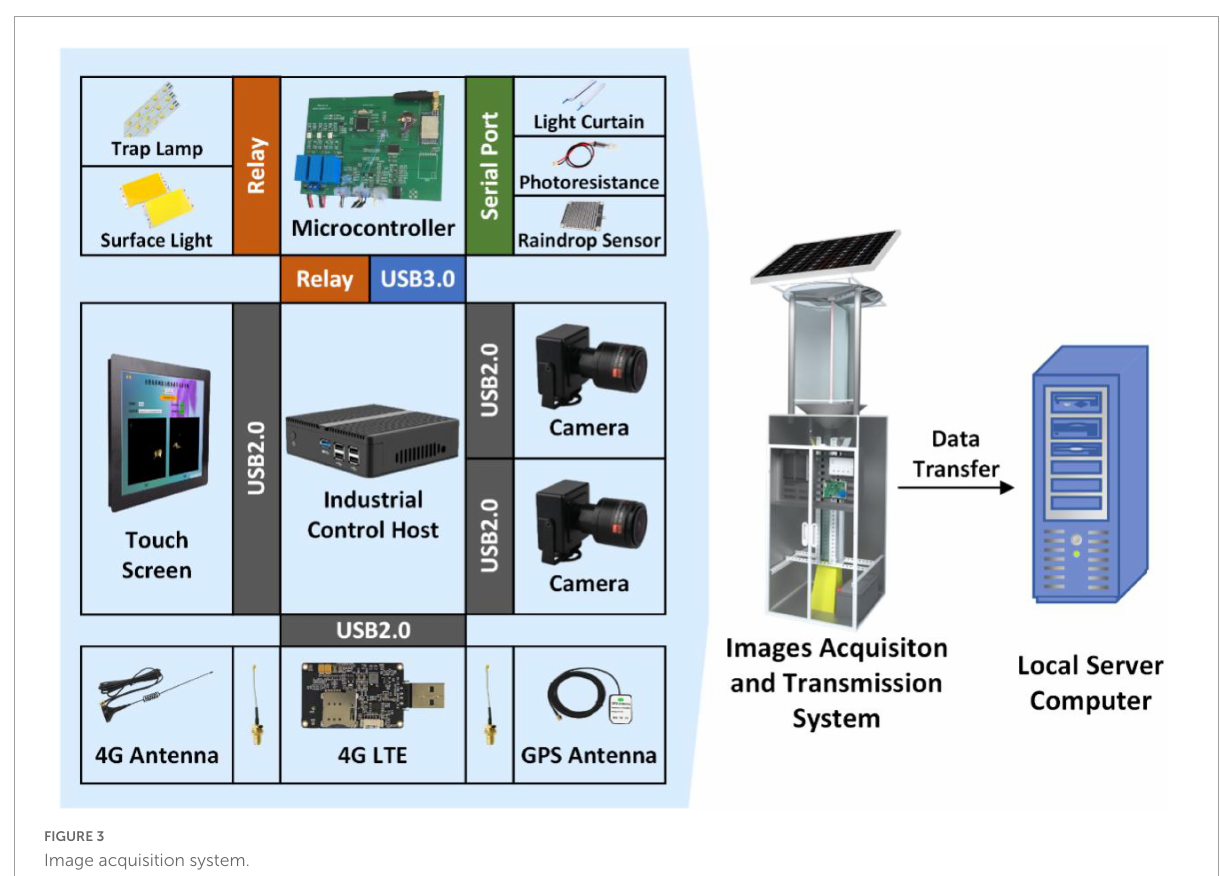
FIGURE3 Image acquisition